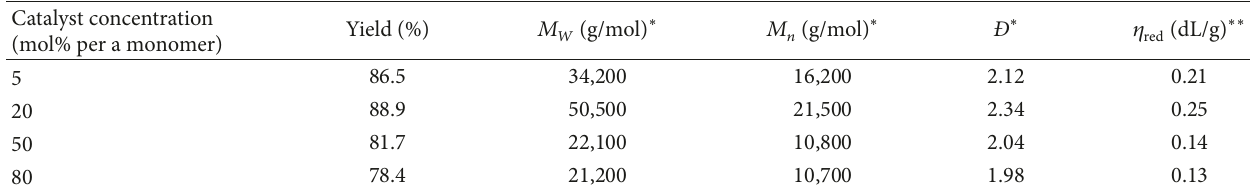
Table 6: The influence of the catalyst concentration on the characteristics of PE8E4. Catalyst